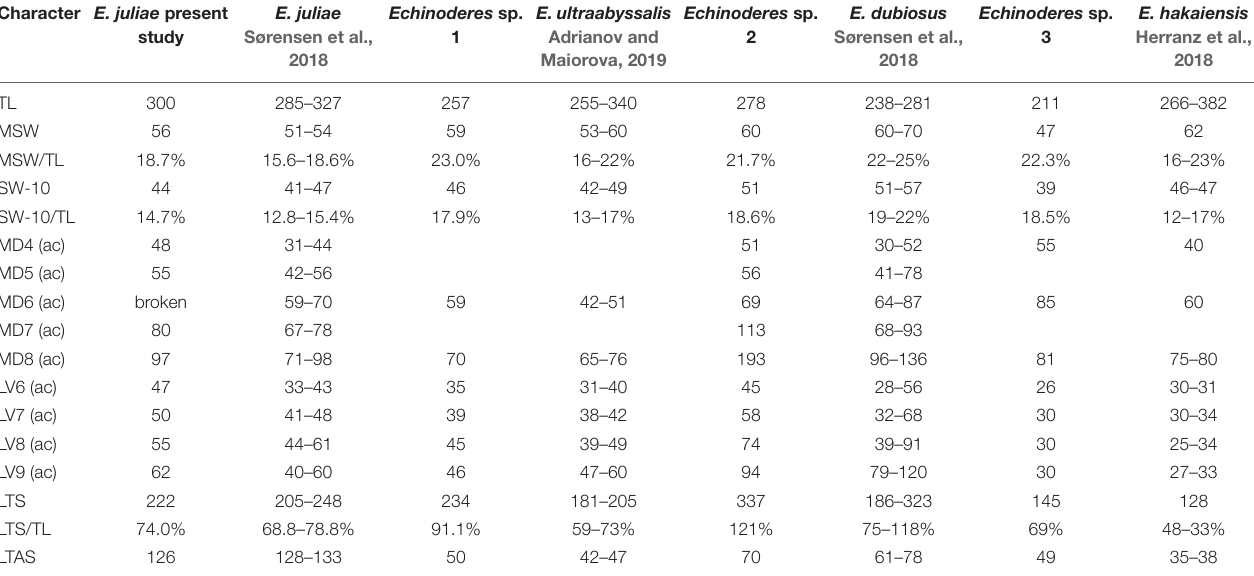
TABLE 4 | Measurements from light microscopy of Echinoderes species from the Atacama Trench with comparison of measurements for the closely related species. Character E. juliae present